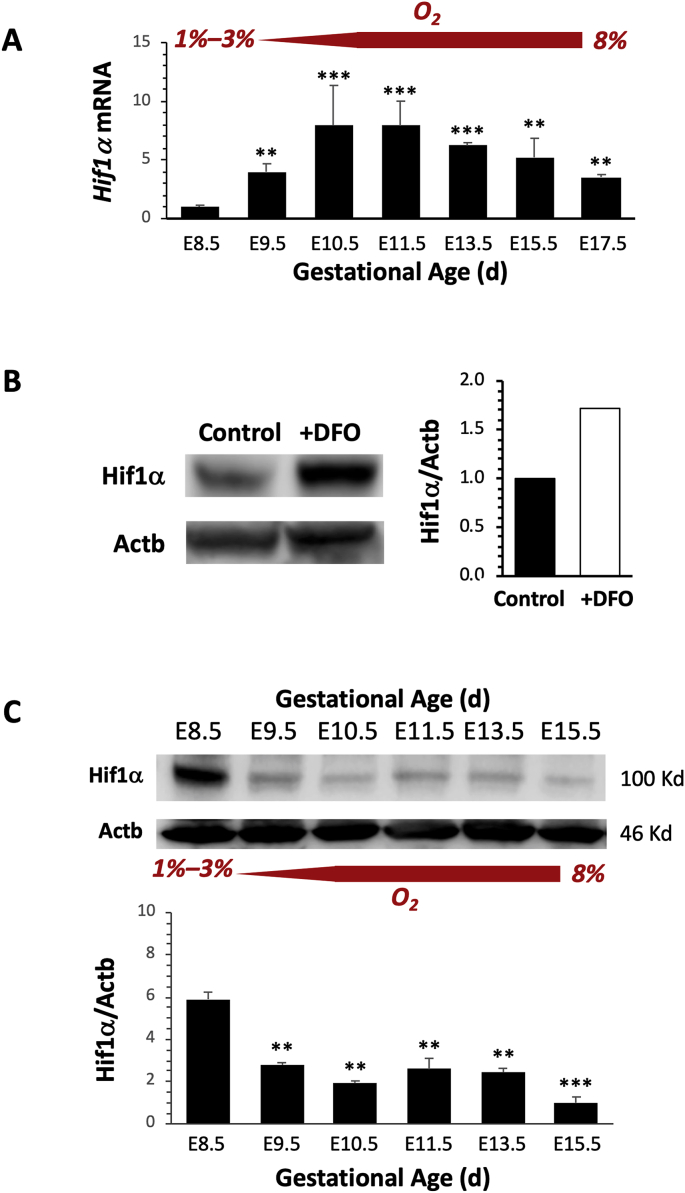
Expression of Hif1α is gestational age-dependent. (A) Hif1α mRNA levels at various gestational ages (n = 3 at each age) were measured using real-time RT-PCR and normalized to Gapdh and Actb levels. Significant upregulation was observed when the placental oxygen (O2) microenvironment increased from 3% to 8% at E9.5 to 10.5. (B) Addition of DFO to placental samples (white bar) helped to preserve Hif1α protein from degradation under ambient oxygen conditions as compared with control (no DFO) samples (black bar) as shown by Western blots. (C) Representative images of Western blots of Hif1α and Actb protein levels (top panel). Band intensities were quantified and normalized to Actb (n = 3). *P < 0.05; **P < 0.01; ***P < 0.005.